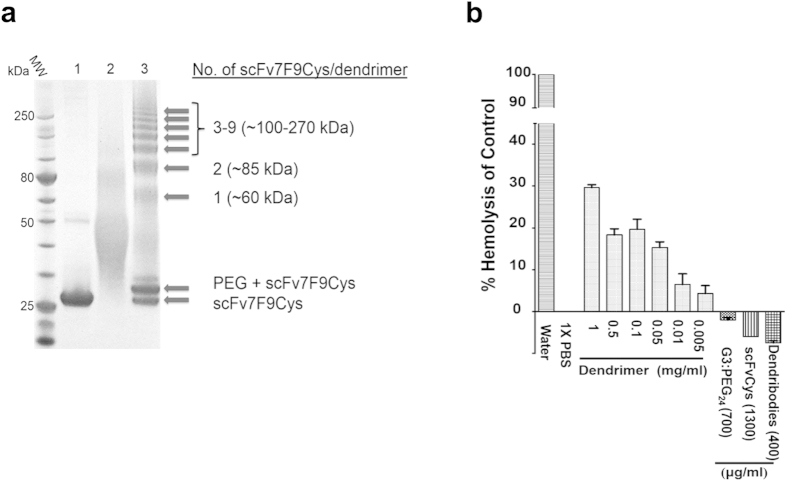
a SDS-PAGE reducing gel showing the PEG24 modified G3 PAMAM dendrimer to scFv7F9Cys (dendribody) crosslinking reaction: (lane 1) purified scFv7F9Cys, (lane 2) PEG24:G3 dendrimer (reaction ratio 11:1), and (lane 3) dendribody conjugation reaction incubated at room temperature and synthesized in conjugation buffer adjusted to pH 6.4. The scFv7F9Cys dendrimer conjugation resulted in higher-order dendribodies with on average, seven scFv7F9Cys molecules conjugated per dendrimer nanoparticle. b
In vitro hemolysis assay to determine the safety of the dendribody medication. G3 PAMAM dendrimers exhibit concentration dependent hemolysis, whereas PEG modified dendrimers, unconjugated proto-type scFv6H4Cys, and dendribodies are non-hemolytic. PEG modified dendrimers, scFv6H4Cys, and dendribodies protected the erythrocytes from hemolysis better than the control buffer (phosphate buffer saline, PBS).